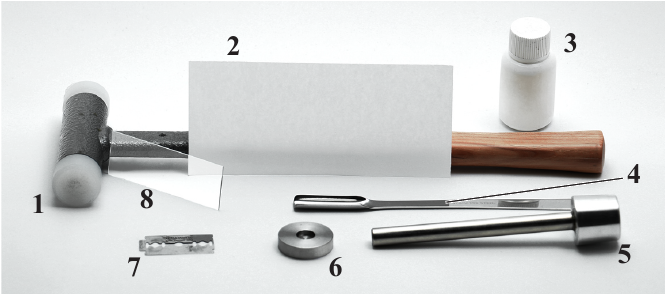
Figure 2. Photograph of the sample preparation components to compress powders into a